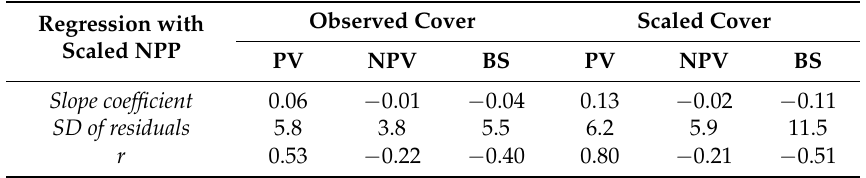
Table 4. Regression of scaled net primary productivity (scaled NPP; from Jackson and Prince [23] with components of fractional cover; photosynthetic vegetation (PV) cover, non-photosynthetic vegetation (NPV) cover, and bare soil (BS) cover and their scaled counterparts. Significance of correlation